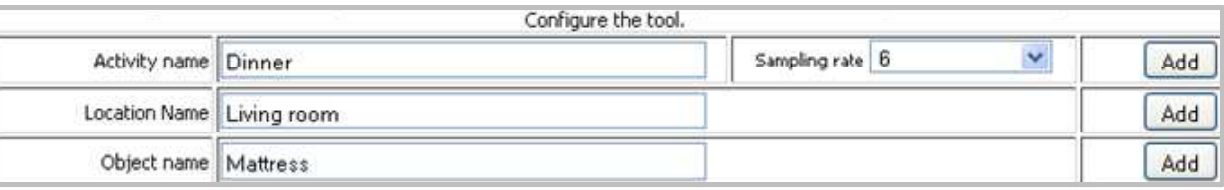
Figure 2. Tool configuration interface.